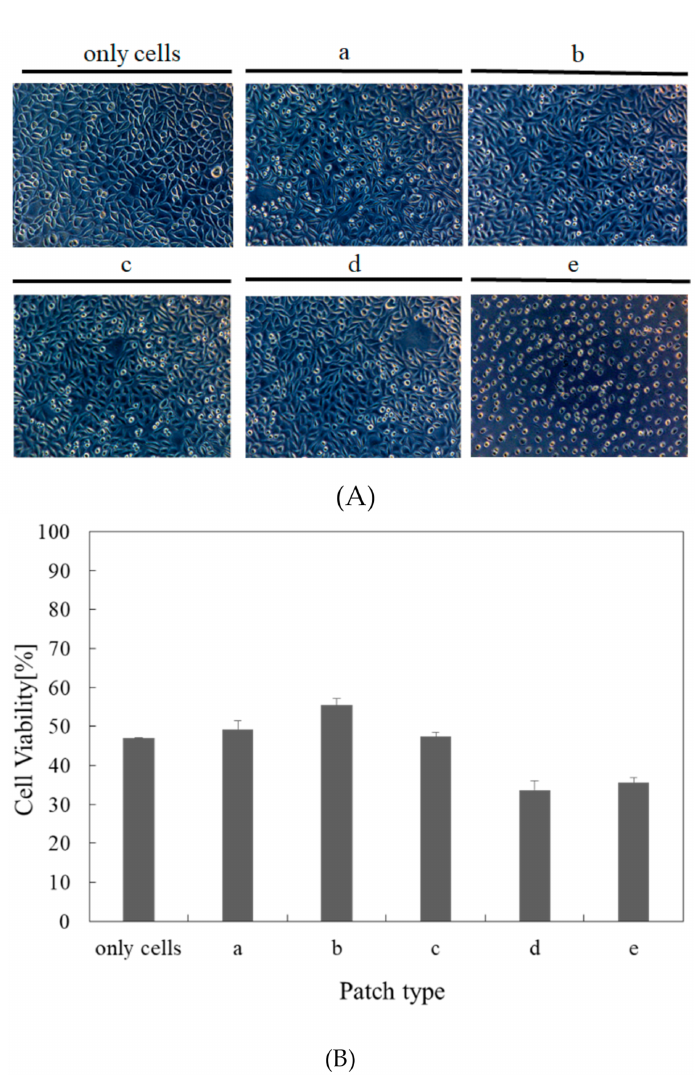
Figure 8. Biocompatibility of Centella asiatica extract (CAE)-loaded hyaluronic acid-dextran (HA-Dex) hybrid hydrogel patches. ( A ) Relative density and ( B ) relative viability of L929 cells treated with CAE-loaded HA-Dex hybrid patches ( n = 3, mean ± SD). (a) 9.8:0.2, (b) 9.6:0.4, (c) 9.4:0.6, (d) 9.2:0.8, and (e) 9:1 wt% HA-Dex: